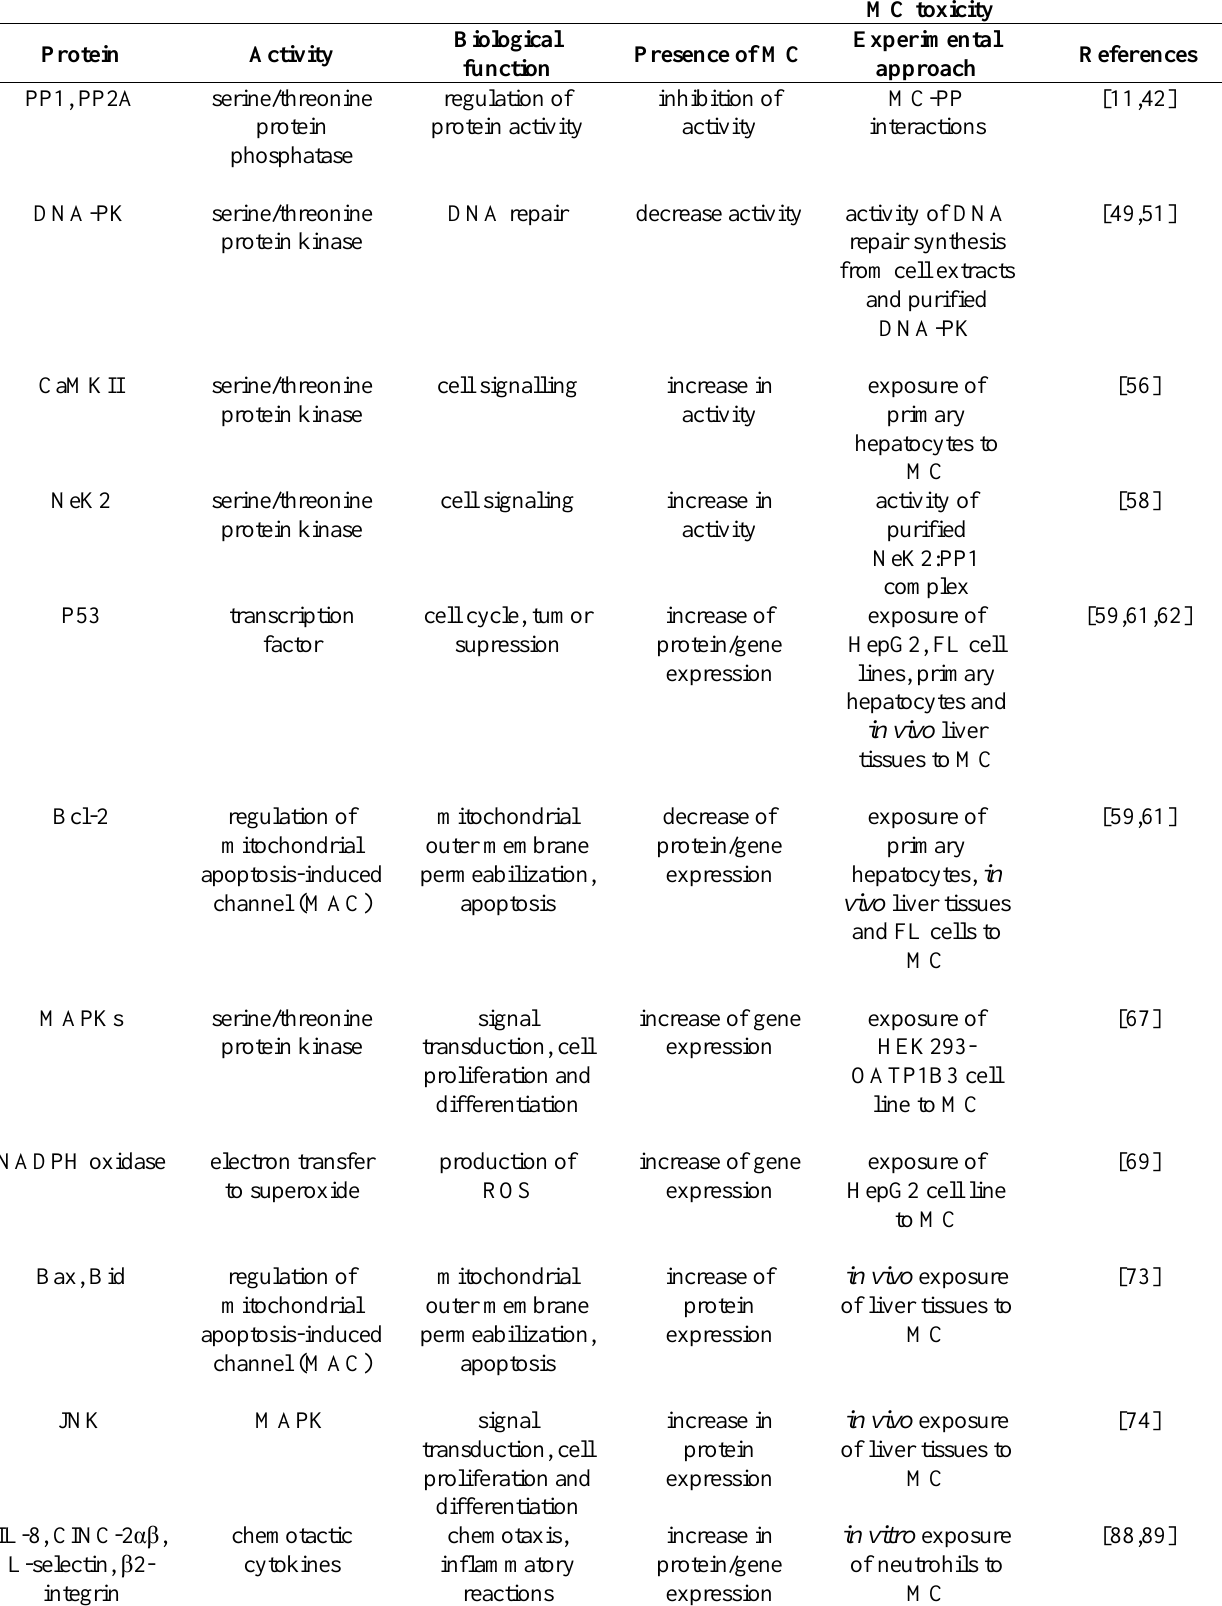
Table 1. List of proteins expressed in animal cells with functions in the processes of MC up-take, toxicity and